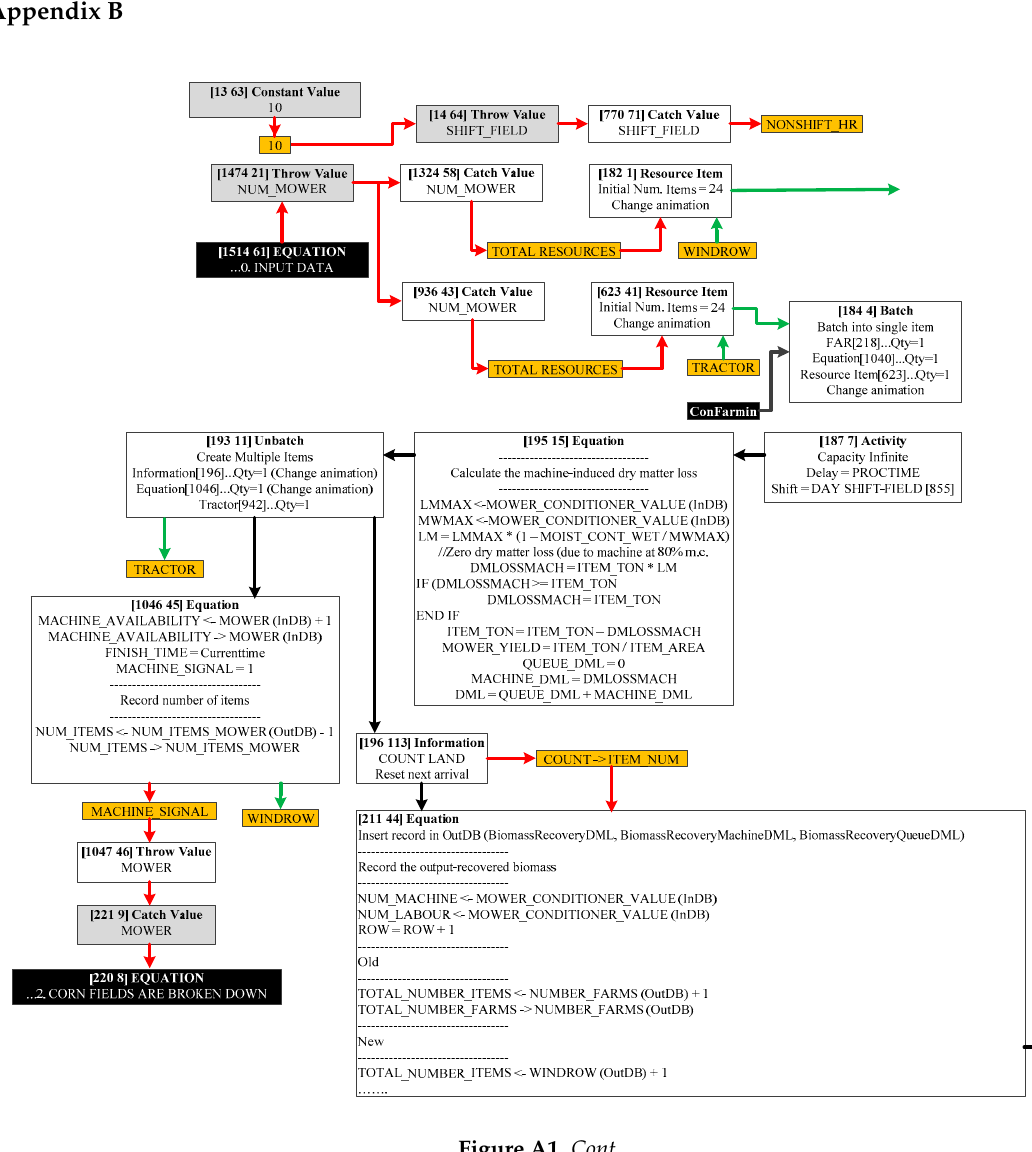
Figure A1. Cont. Figure A1.